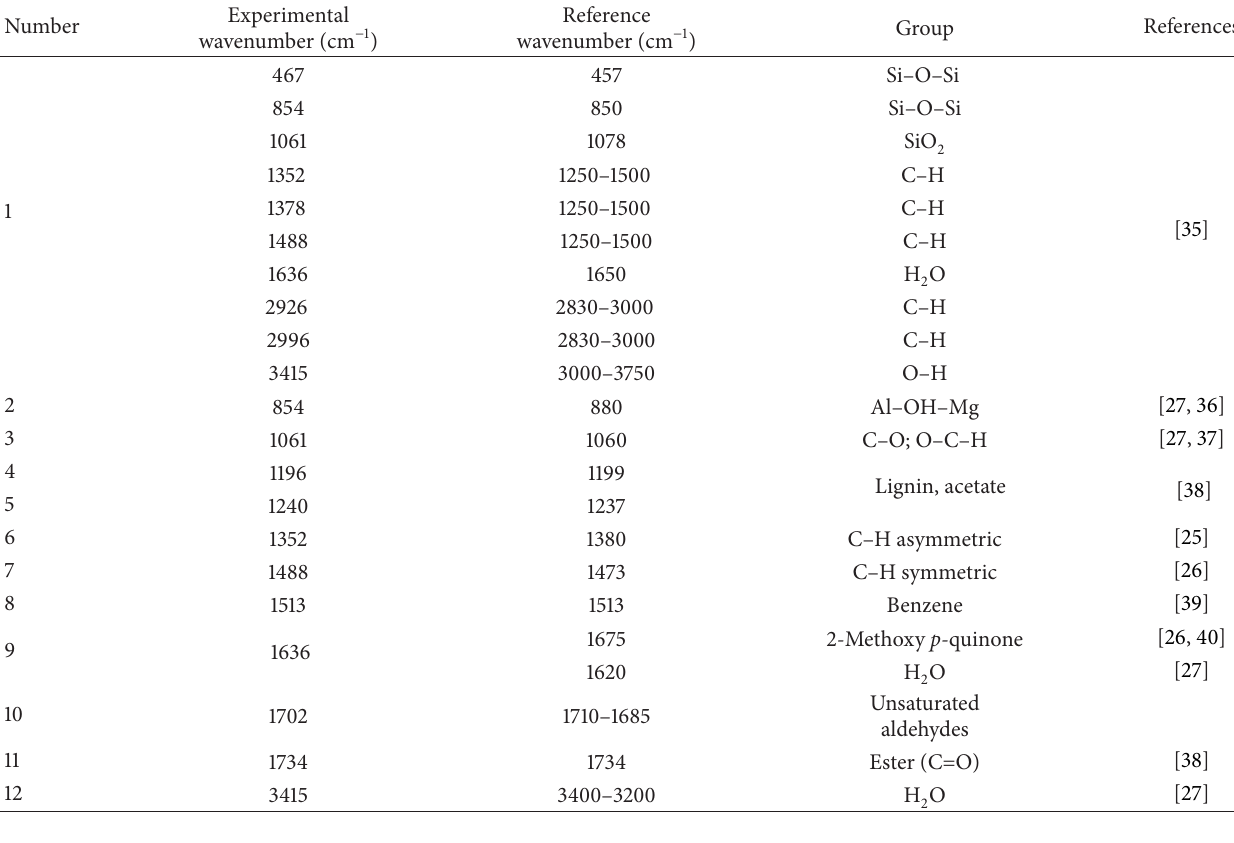
Table 2: IR analysis of the green section of the exterior wall of GAKVB.